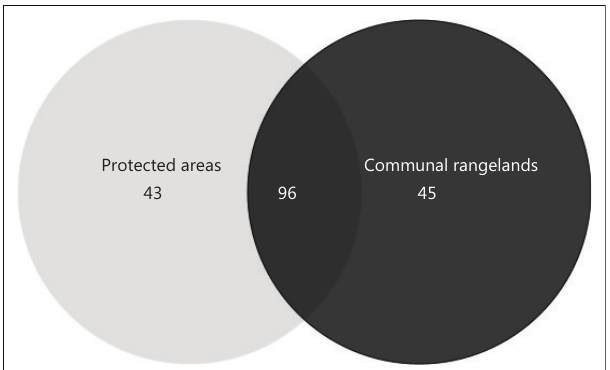
FIGURE 11-A1: A Venn diagram showing the number of plant (trees, grass and forb) species shared between and unique to protected areas and communal rangelands.